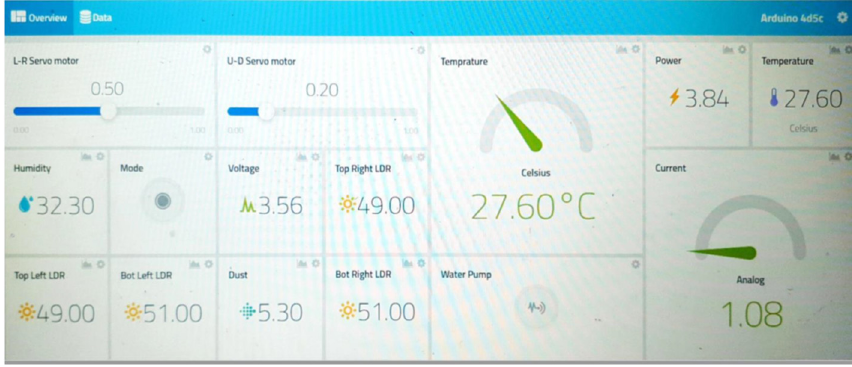
Figure 7. Control screen of the photovoltaic system.